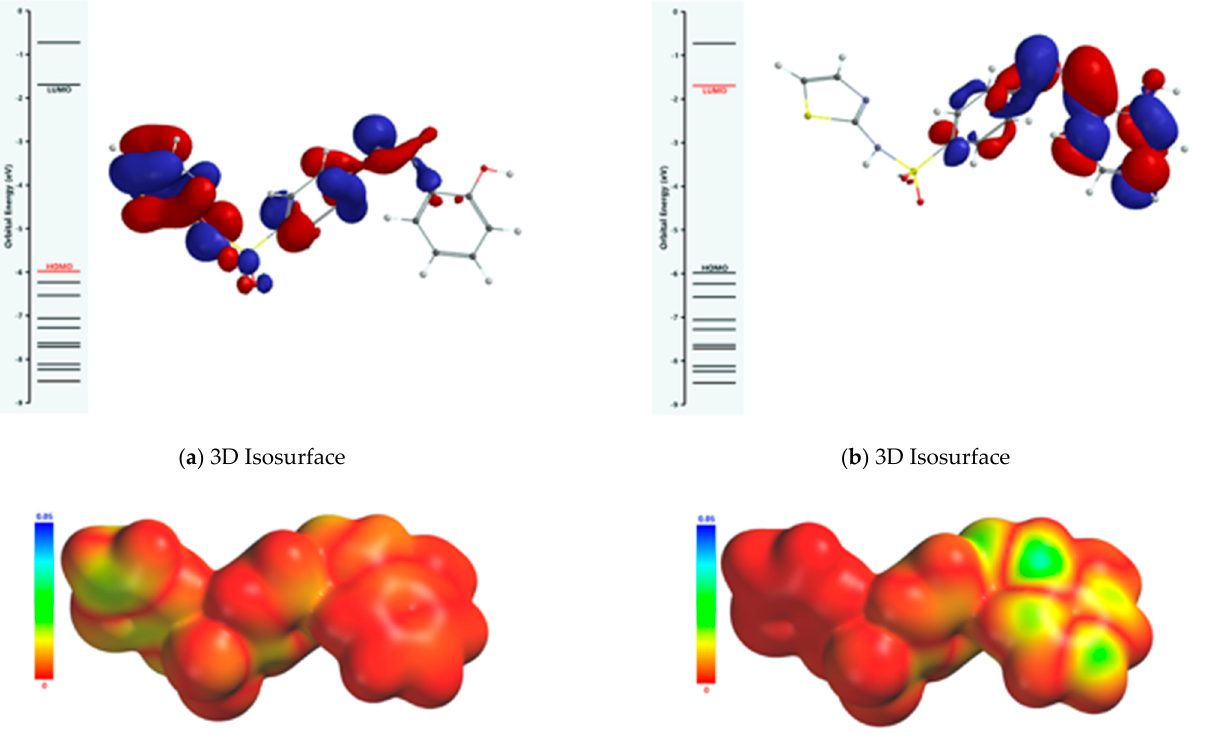
Figure 9. Frontier molecular orbitals (FMOs) of the Schiff base ligand. The atoms of the Schiff base involved in the coordination of the transition metal were also identified from the 3D graphical model of the effective distribution of the electrons in the ligand molecule. This was obtained by mapping the molecular electrostatic potential on an isodensity surface of 0.002 electrons/a.u. 3 , which approximated the van der Waals radius of the ligand molecule (Figure 10). The 3D map of the spatial distribution of the electrons in the ligand molecule highlighted the following: (a) the size of the ligand molecule and its shape that excludes steric hindrances determine the coordination of the transition metal with the formation of an octahedral geometry, and (b) the reactive centers on the molecular surface correspond to the more negative values of the molecular electrostatic potential and are adjacent to the oxygen atom of the phenolic group and to the nitrogen atoms of the azomethine group and the thiazole ring. The atoms in the ligand molecule participating in the covalent interactions with the metal ion were also confirmed by the 3D graphical model obtained by mapping the ionization potential on the surface of the total electric charge density (Figure